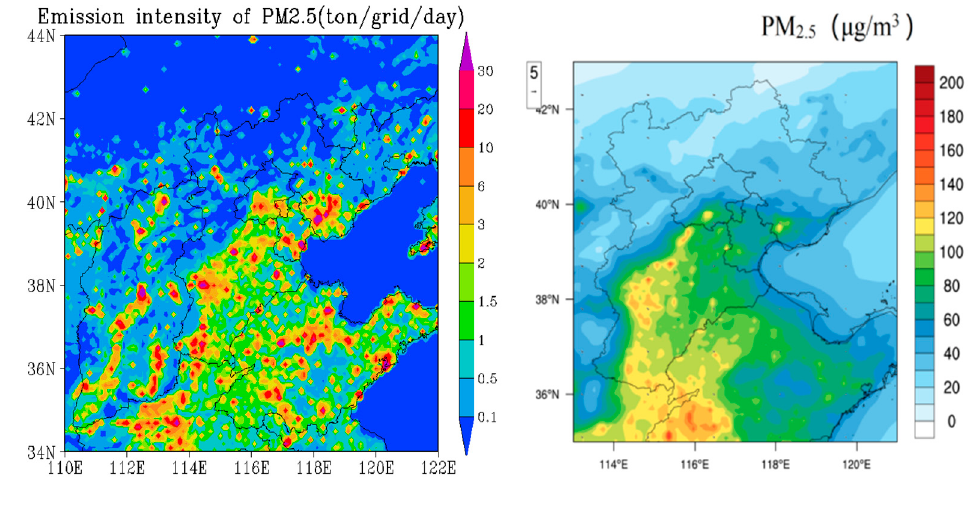
Figure 3. Hourly PM 2.5 concentration and meteorological parameters in the region.